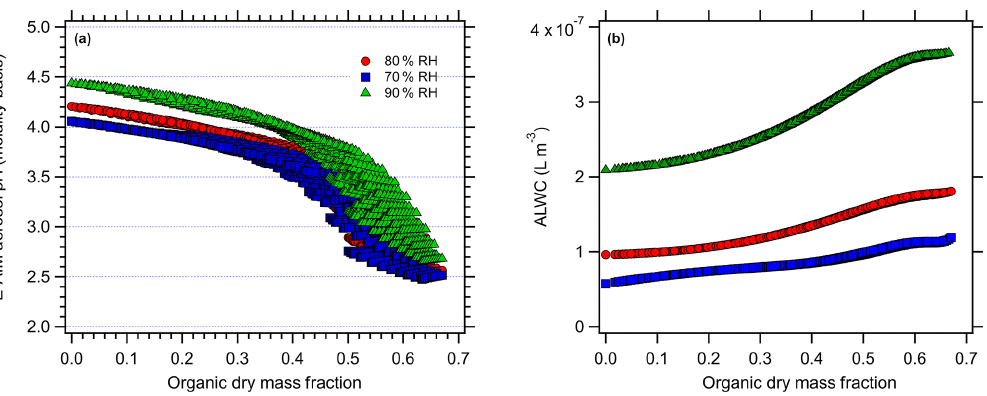
Figure 5. E-AIM-modeled (a) aerosol pH (molality basis) and (b) ALW at 70% (blue), 80% (red), and 90% RH (green) levels for the Beijing simulations with organic